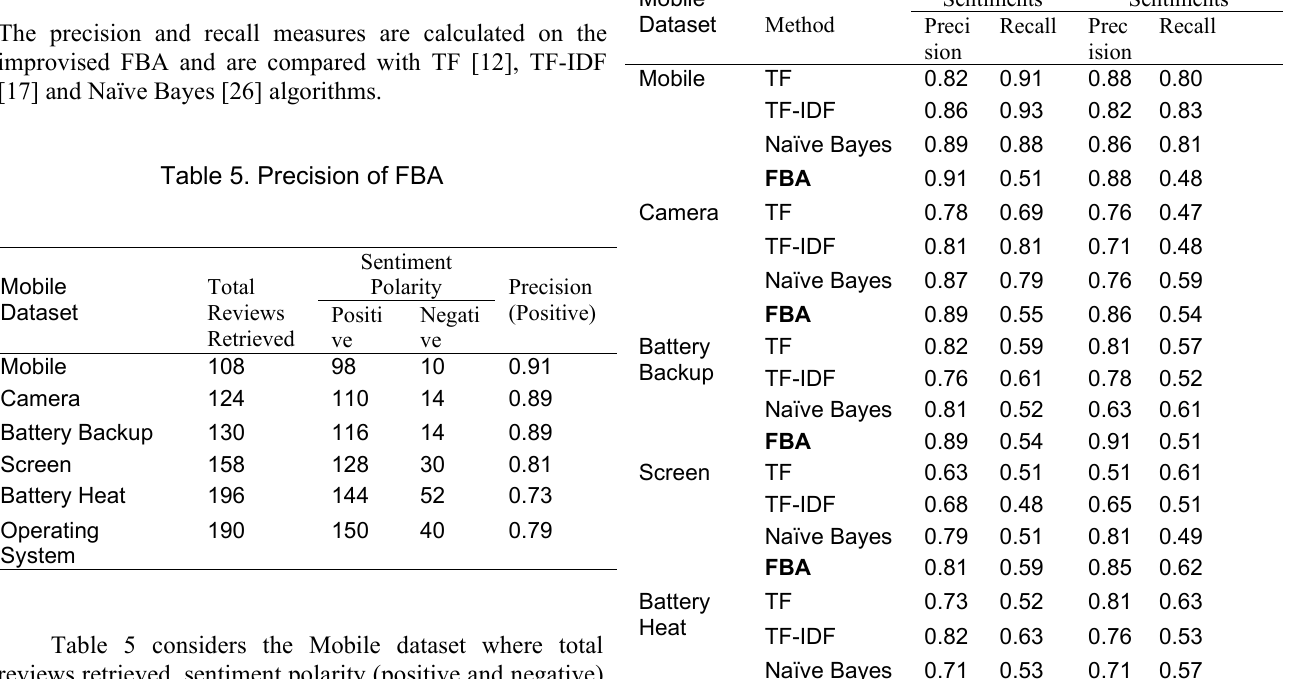
Table 6 considers the Mobile dataset where total